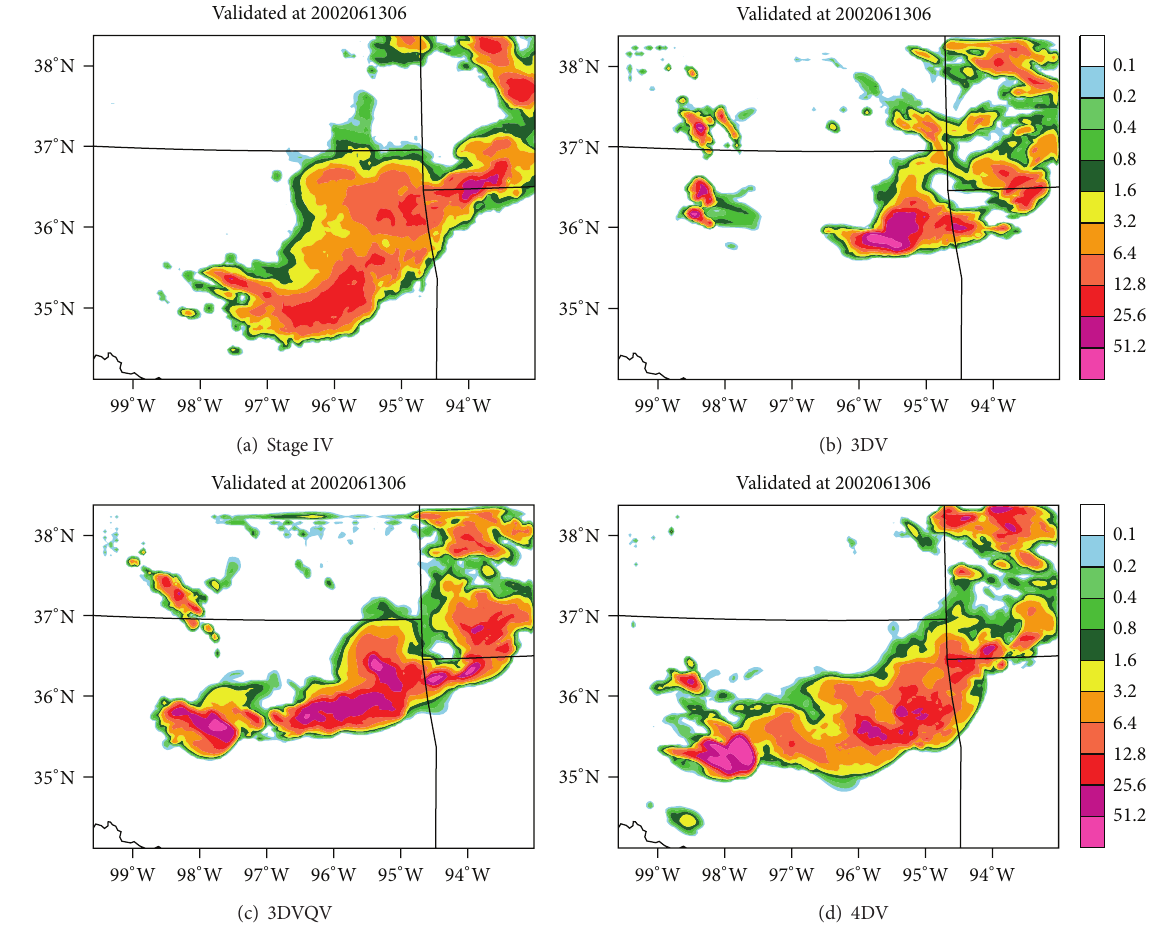
Figure 5: 6-hour forecasts of hourly accumulated precipitation (mm) from (b) the basic WRF 3D-Var (3DV), (c) the enhanced WRF 3D-Var (3DVQV), and (d) the 4D-Var (4DV). The Stage IV precipitation analysis is shown by (a) for